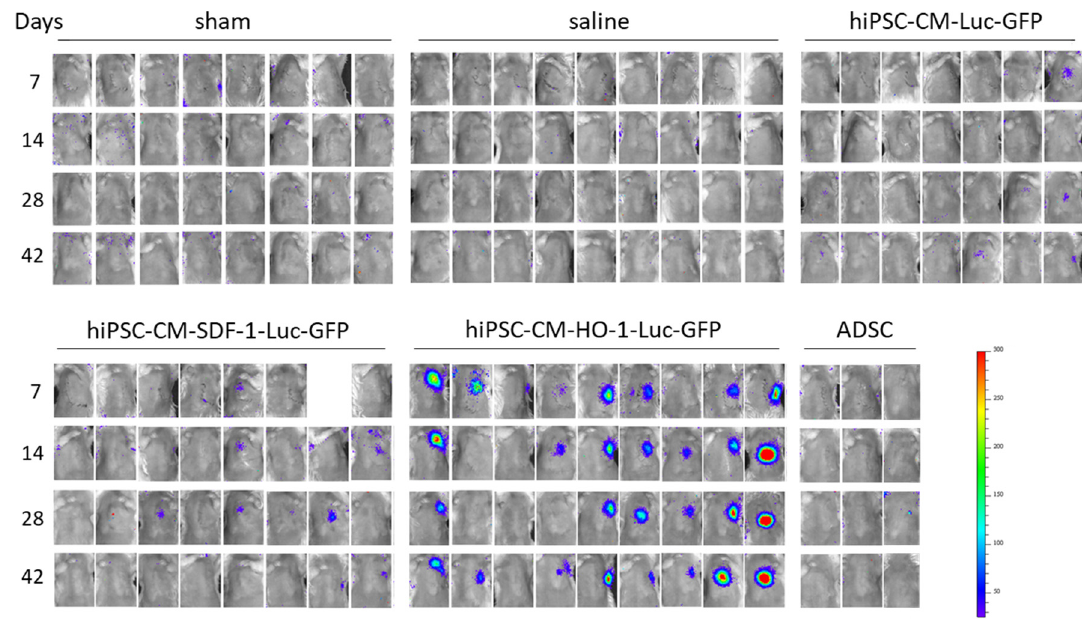
Figure 5. Detection of human cells in murine hearts in vivo. Bioluminescent signal collected intravitally on days 7, 14, 28 and 42 after MI induction from the chest of all animals used in the experiment. N = 3 (ADSC) or 7–9 animals/group.